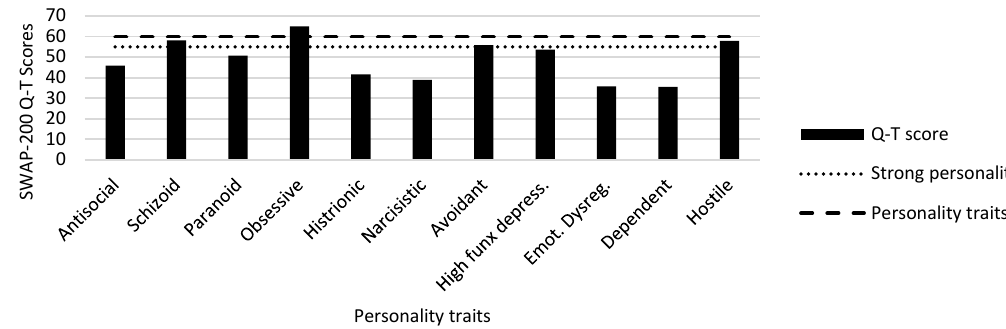
Figure 8: Margherita’s SWAP-200 6-month follow-up 1 Q-T